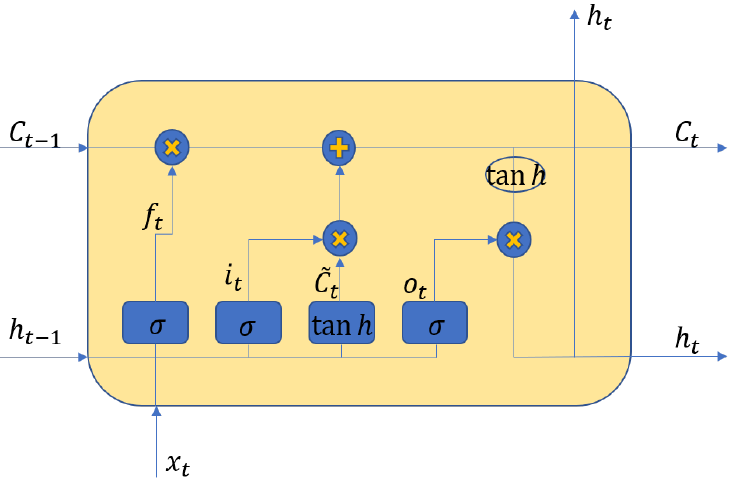
Figure 3. Schematic of the LSTM’s